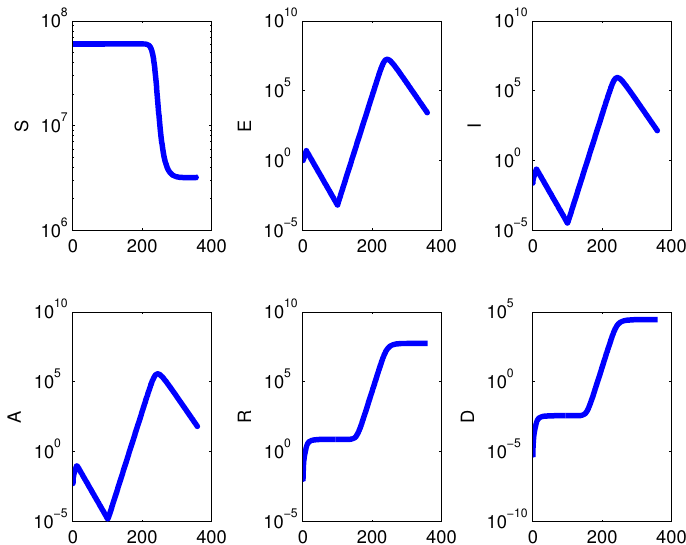
Figure 4. Using a semilogarithmic scale for the vertical axis, we show the results of starting the restrictions at time t 1 = 10, using β I = 10 − 10 and lifting them at time t 2 = 90, returning to β I = 10 − 7 three months later, over a one year timespan for the model with demographics (1). Left to right and top to bottom, the subpopulations are: S , E , I , A , R and D , the disease-related deceased class.